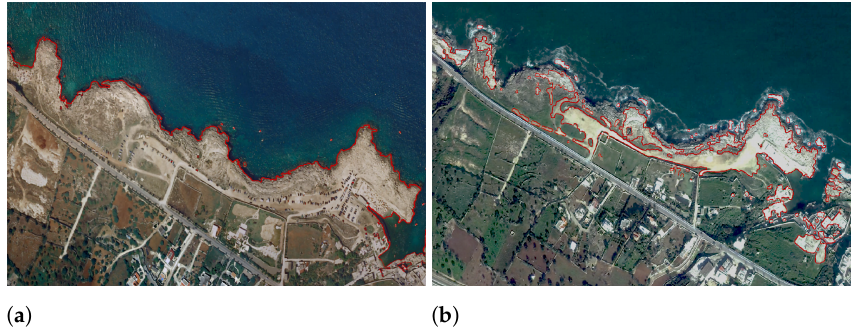
Figure 12. Comparison between shoreline detected during calm and rough sea. Example of the influence of waves foam on the shoreline detection. ( a ) Rocky beaches shoreline extraction along Apulian region during calm sea. ( b ) Rocky beaches shoreline extraction along Apulian region during rough